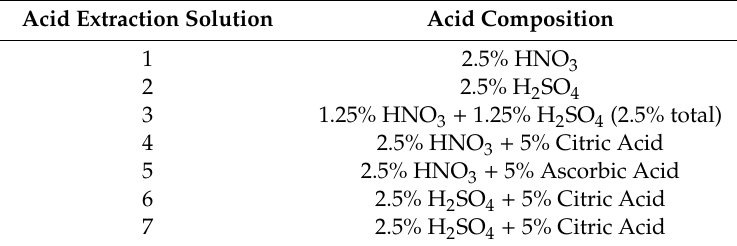
Table 1. List of Acid Extraction Solvents.